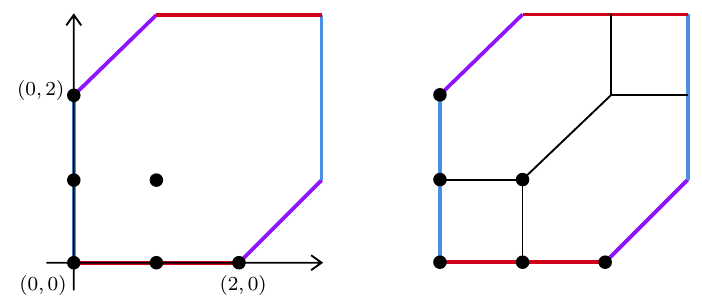
Figure 12 . Mixed decompositions in ( z 1 ; z 2 )-plane: for init a (left) and init b (right).